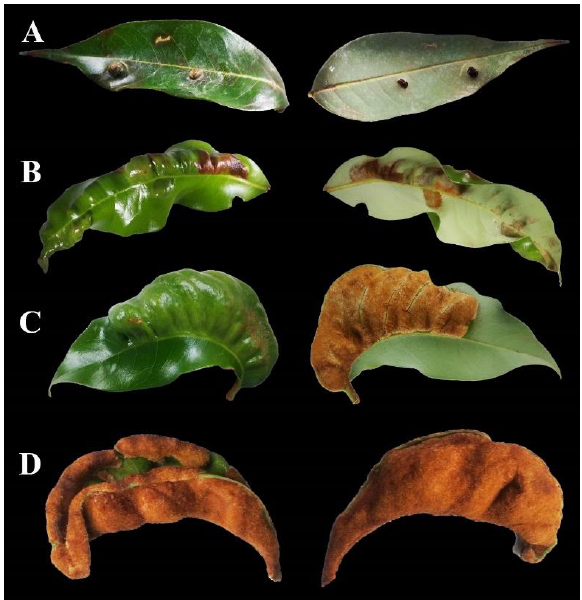
Figure 2. Erinea types associated with different levels of infestation of LEM-topside on left, underside on right (note that most of the topside of ( D ) is obscured because the leaf has folded). ( A ) Low level of infestation. ( B ) Moderate level of infestation. ( C ) High level of infestation. ( D ) Extreme level of infestation (topside of leaf with some erineum hairs).